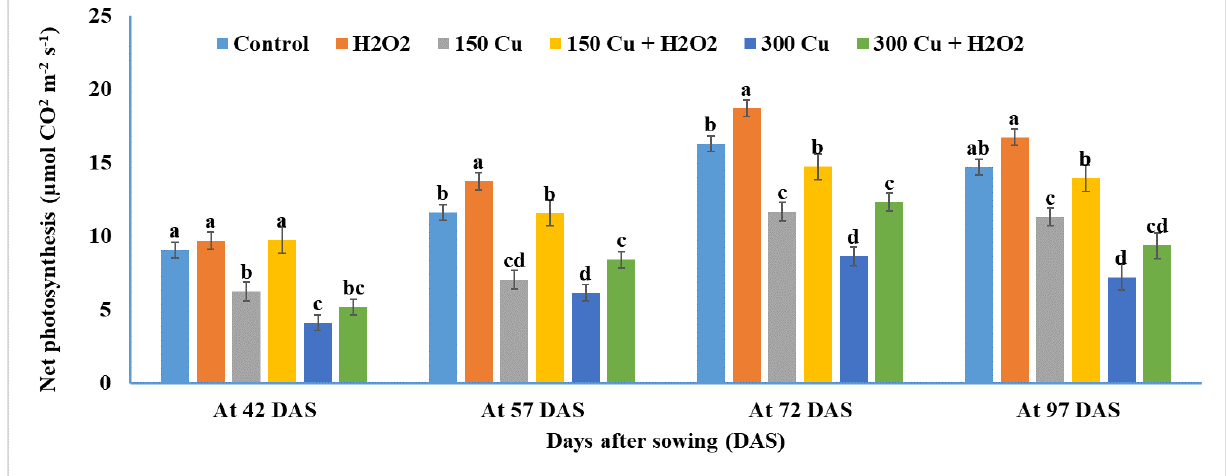
Figure 5. Effect of hydrogen peroxide on net photosynthesis at 42, 57, 72, and 97 DAS of wheat grown in contaminated sandy soil. Means followed by the same letter at each sampling date are not significantly different according to the least significant differences (LSD) test ( p ≤ 0.05). Error bars are ± Standard Error (SE).